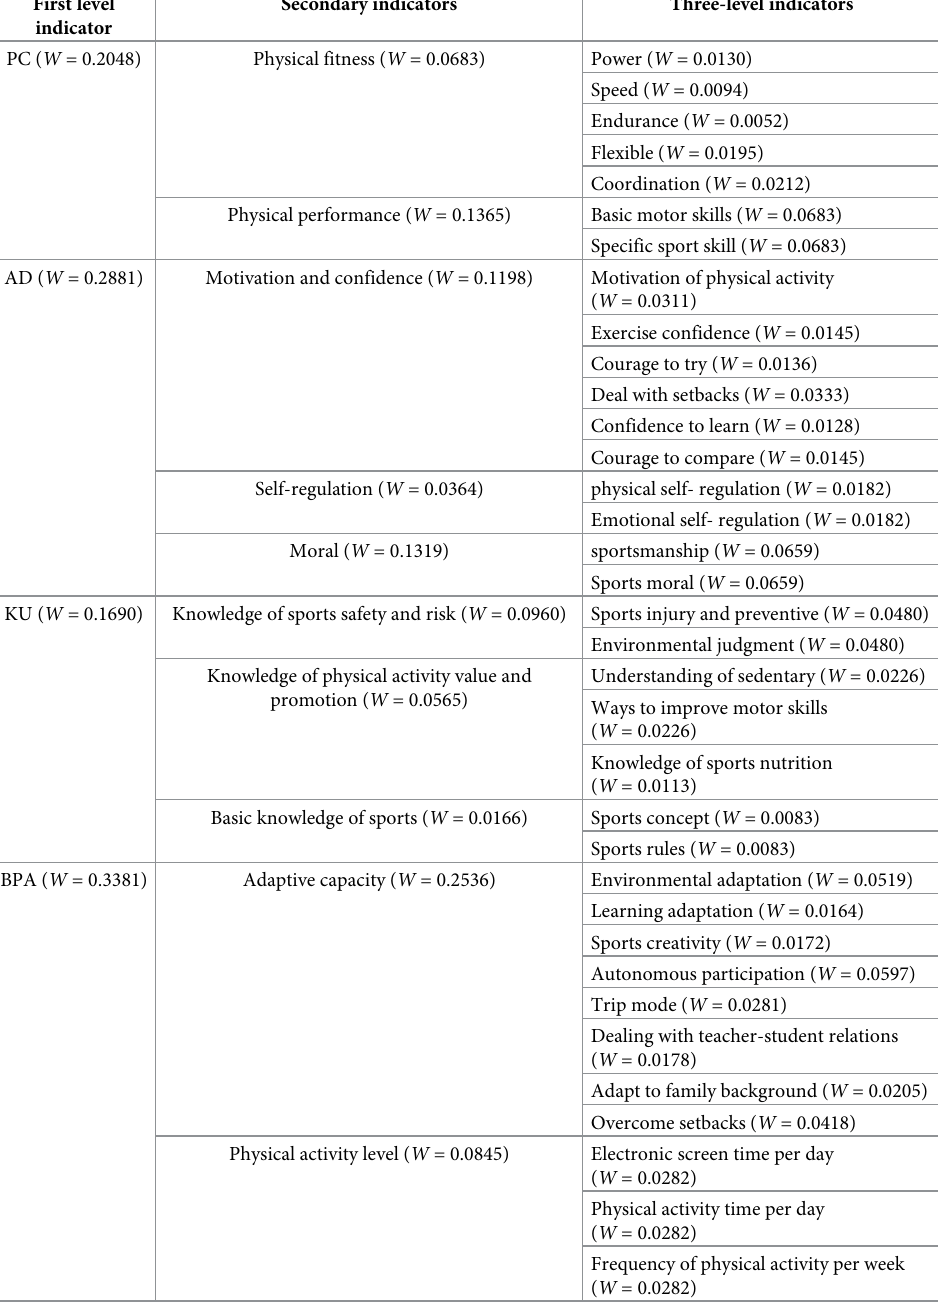
Table 5. The weights of the physical literacy evaluation indicators for Chinese students in grade